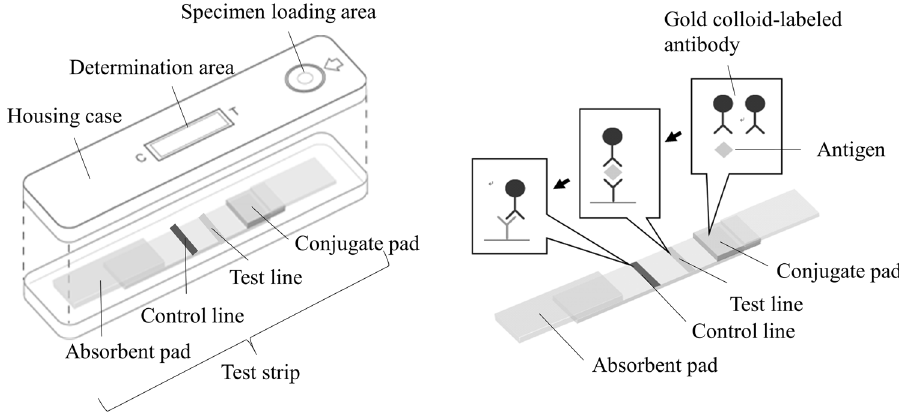
Figure 1. Structure and principle of the immunochromatographic antigen kit (ICkit). This product is a kit that detects Bordetella pertussis antigen in a nasopharyngeal swab specimen by immunochromatography. The kit includes reagent A, reagent B, and a test plate that consists of a test strip and a housing case. The specimen is applied to the test plate after pretreatment with reagent A and reagent B. The specimen moves over the test strip by capillary action. When the specimen reaches the conjugate pad, the antigen causes an antigen–antibody reaction with the gold colloid-labeled monoclonal antibody (mouse) bound in the conjugate pad and forms an immunocomplex. This immunocomplex flows to the absorbent pad through the nitrocellulose membrane by capillary action. When reaching the test line, it is captured by the immobilized monoclonal antibody to form a sandwich immunocomplex. The sandwich immunocomplex results in a purplish-red line appearing at the determination part on the test plate. The presence or absence of this line can thus determine the presence or absence of the B. pertussis antigen. The control line appears as a purplish-red line of gold colloid-labeled monoclonal antibody when this antibody flows over the membrane and binds to a solid-phase